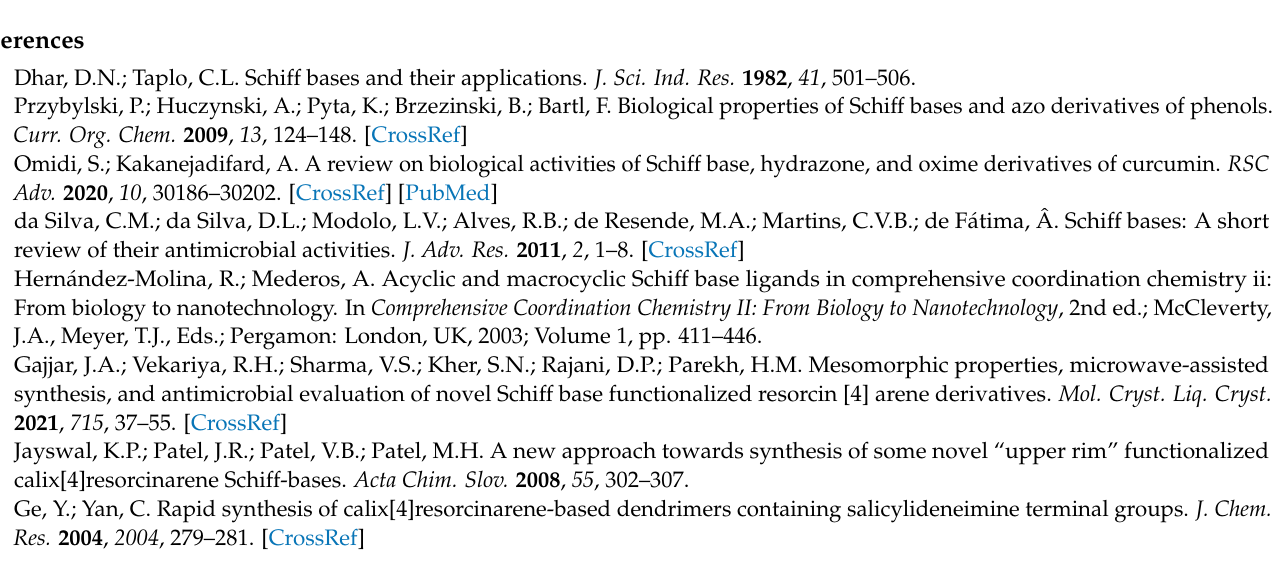
Figure S1. 1 H and 13 C NMR spectra of salRA in DMSO- d 6 ; Figure S2. 1 H and 13 C NMR spectra of dmaeRA in DMSO- d 6 ; Figure S3. IR spectrum of salRA; Figure S4. IR spectrum of